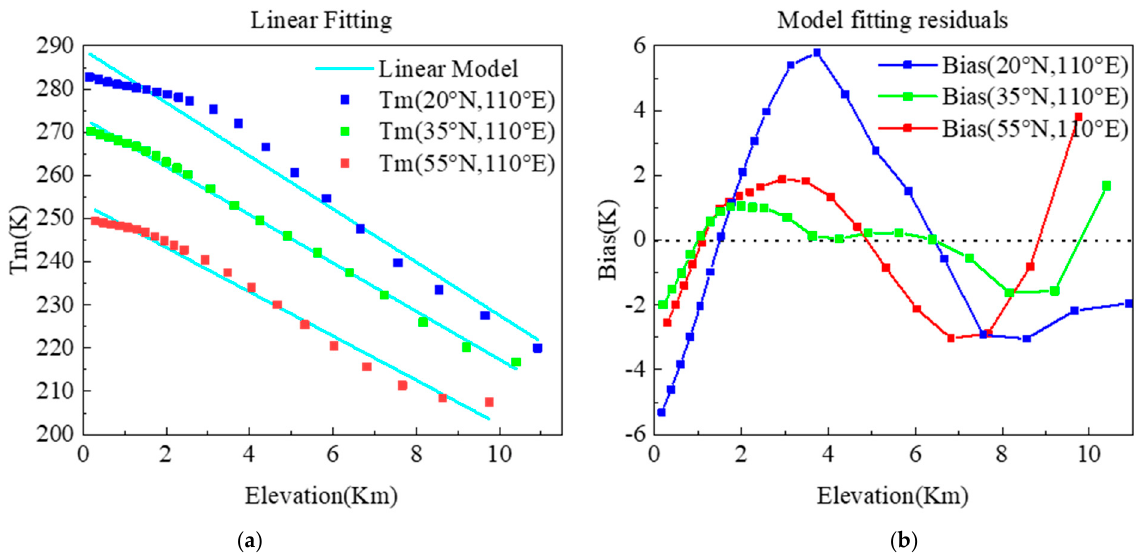
Figure 3. Fitting effect of linear function model ( a ) and its residual ( b ).